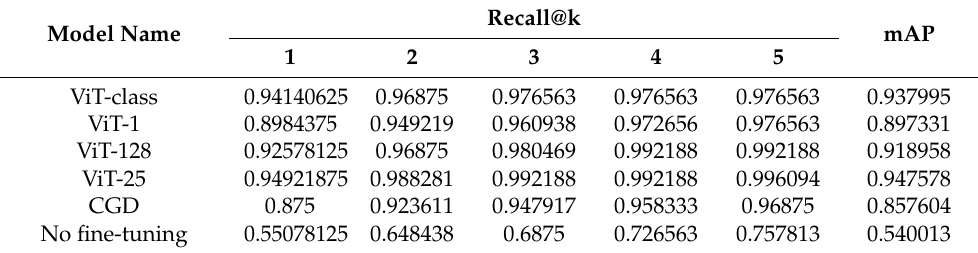
Table 6. Recall@k and mAP comparison of different representation output via ViT-based